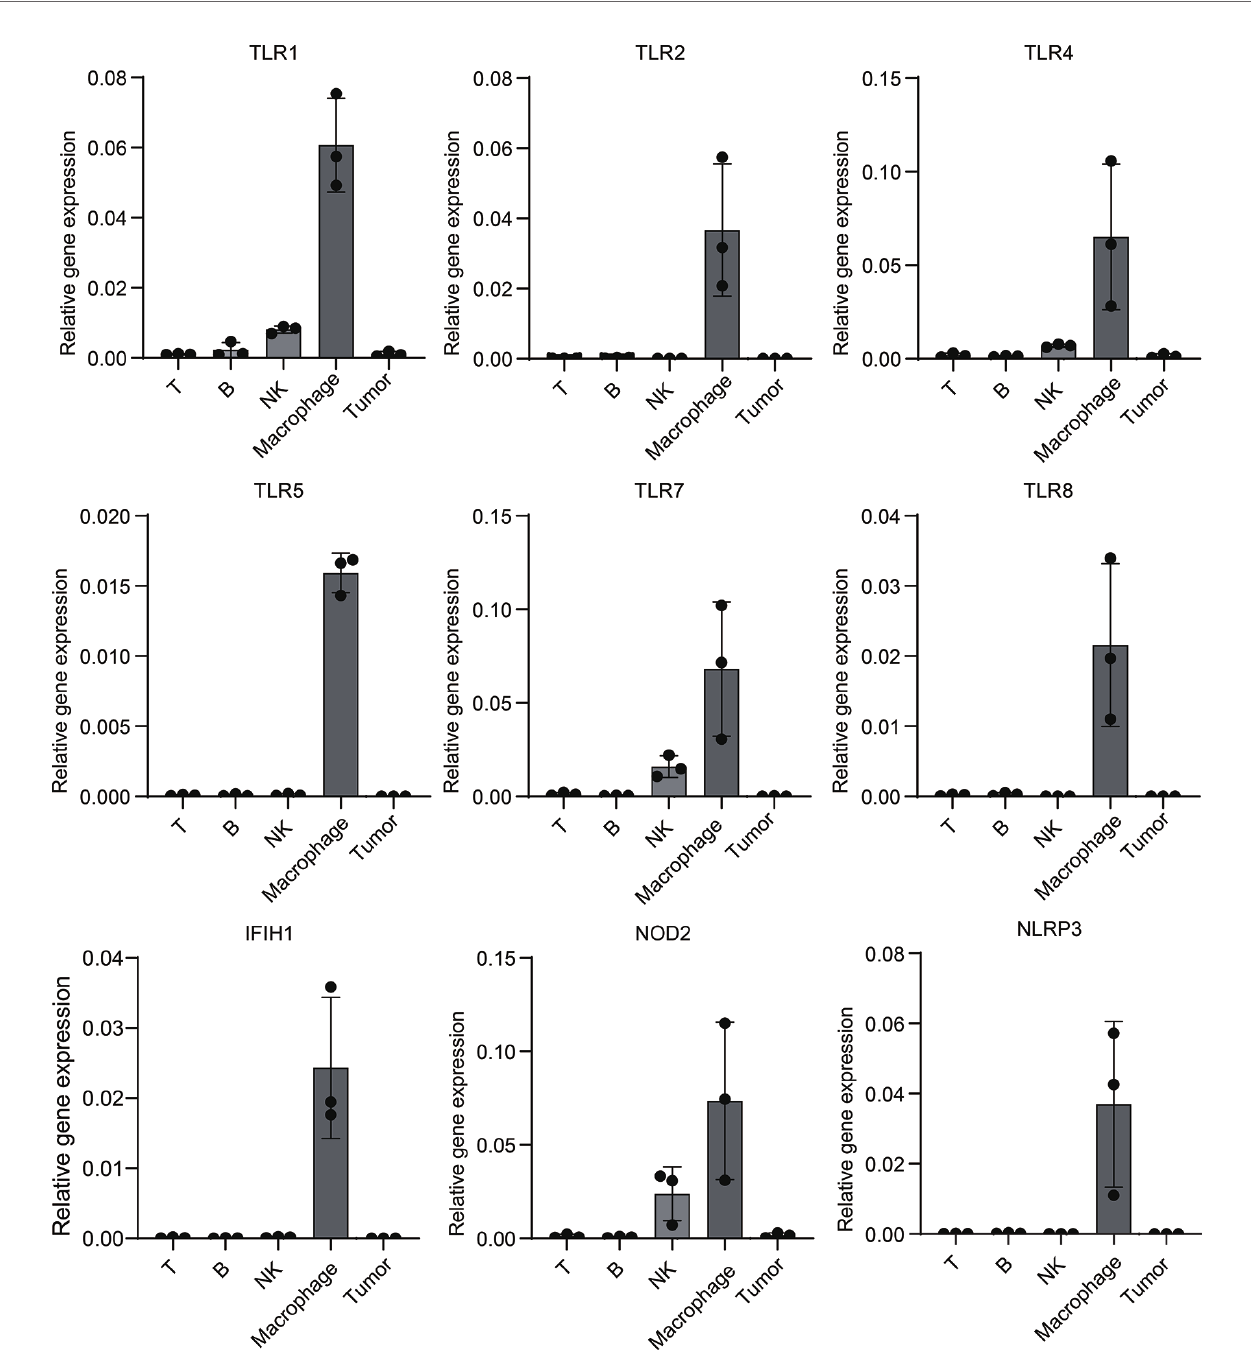
FIGURE 7 | Mouse model experiment shows PRRs ’ speci fi c expression on macrophages in melanoma samples. Melanoma cell line B16 cells were injected into subcutaneous of C57/B6-L mice (n=3), after injection of 18 days, different types of immunocytes were isolated, and then total RNA were extracted. After RT-PCR, qPCR analysis was performed to detect the expression of PRRs. The relative expression of PRRs were normalized to that of GAPDH. Results were analyzed in GraphPad Prism version